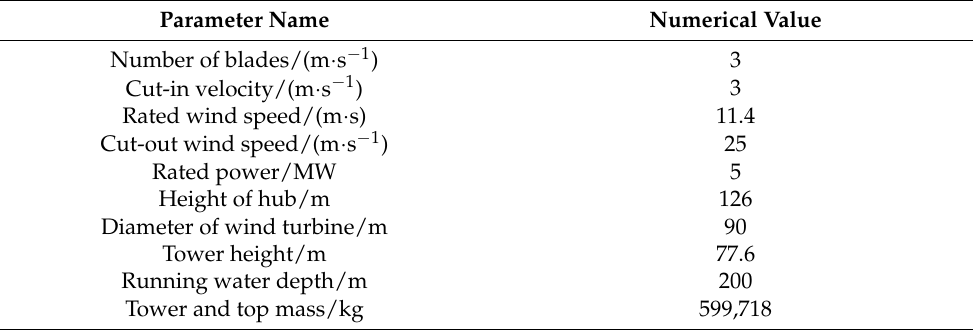
Table 1. Parameters of floating wind